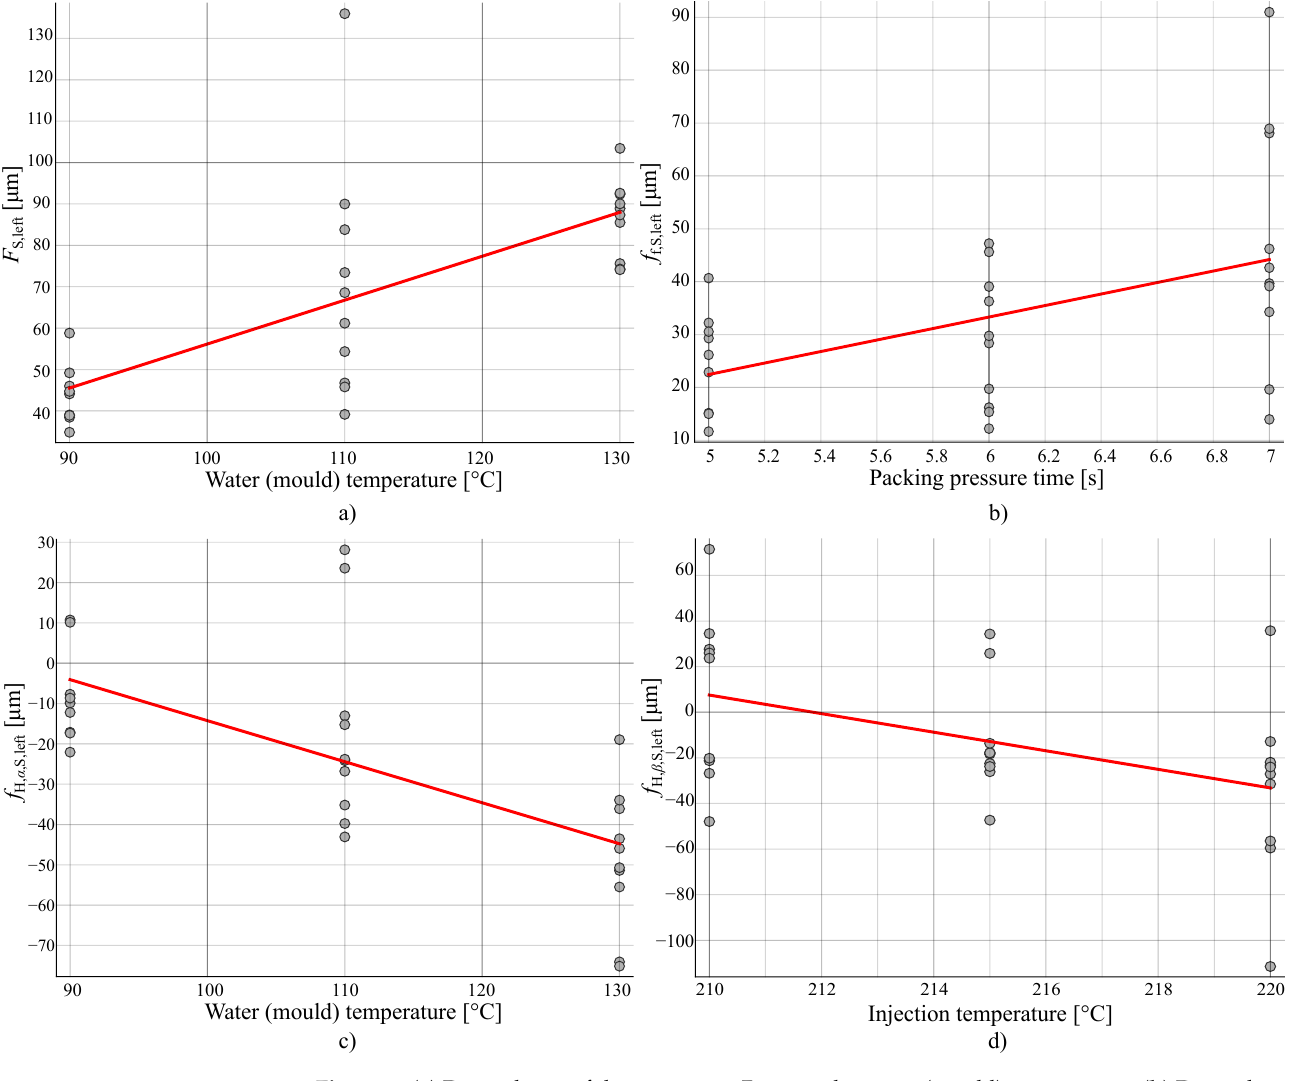
Figure 9. ( a ) Dependency of the parameter F S,left on the water (mould) temperature. ( b ) Dependency of the parameter f f,S,left on the packing pressure time. ( c ) Dependency of the parameter f H, α ,S,left on the water (mould) temperature. ( d ) Dependency of the parameter f H, β ,S,left on the injection